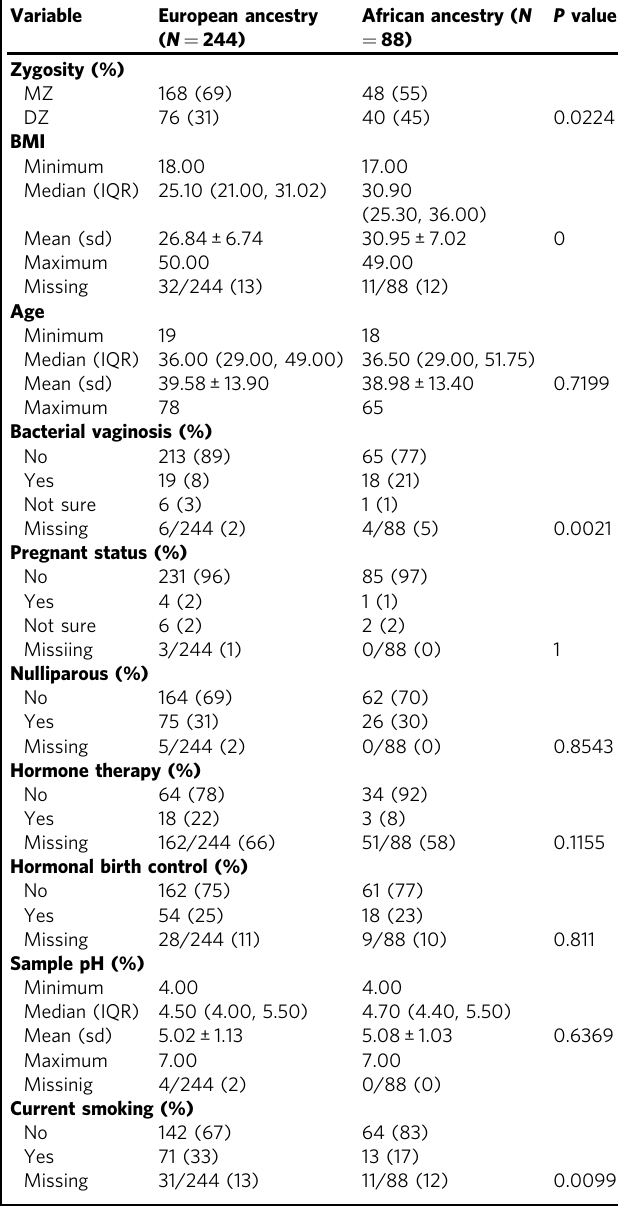
Table 1 Reproductive health characteristics of twin participants by self-reported